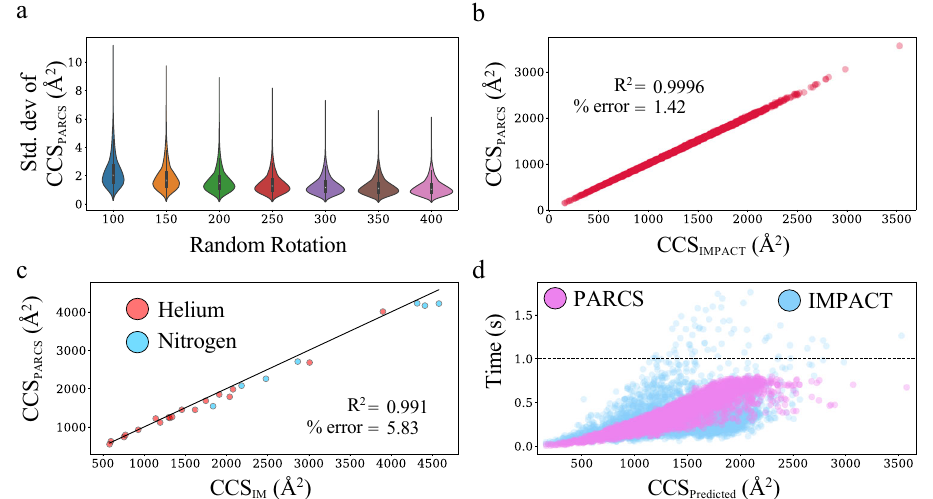
Fig. 1 | Analysis of projection area using rough circular shapes (PARCS) algo- rithm.a Convergenceofcollisioncrosssection(CCS)calculationusingPARCSwas testedon, n =4465,biologicallyindependentsamples(crystalstructuresdeposited in the Protein Data Bank [PDB]) over 100 independent runs for 7 separate cate- gories of random rotations ranging from 100R400 random rotations. The mean and the standard error of the mean for these distributions of 100R400 random rotations were 2.257 ± 0.016 Å 2 , 1.852 ± 0.013 Å 2 , 1.598 ± 0.011 Å 2 , 1.415 ± 0.010 Å 2 , 1.306 ± 0.009 Å 2 , 1.222 ± 0.009 Å 2 , 1.162 ± 0.008 Å 2 respectively. The white dots represent the median in each violin distribution. The black bar in the center of the distribution is the interquartile range (IQR). The black stretched line extends from